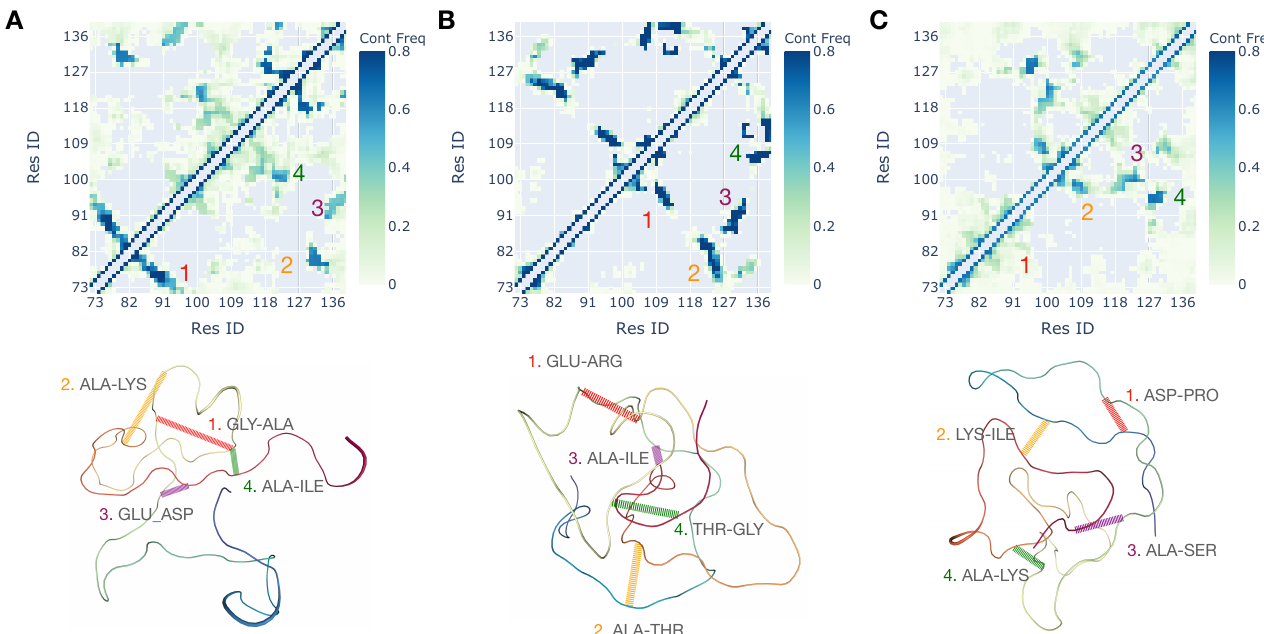
Figure 3. The C α − C α contact frequency maps of HP1 single chain simulations corresponding to the three distinct ionic conditions of 10 mM ( A ), 50 mM ( B ), and 150 mM ( C ). A representative conformation corresponding to contact frequency map is shown along with four highest frequency contact pair hot